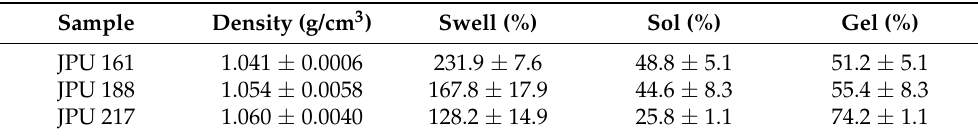
Table 3. Swelling and sol fraction of JPU films in